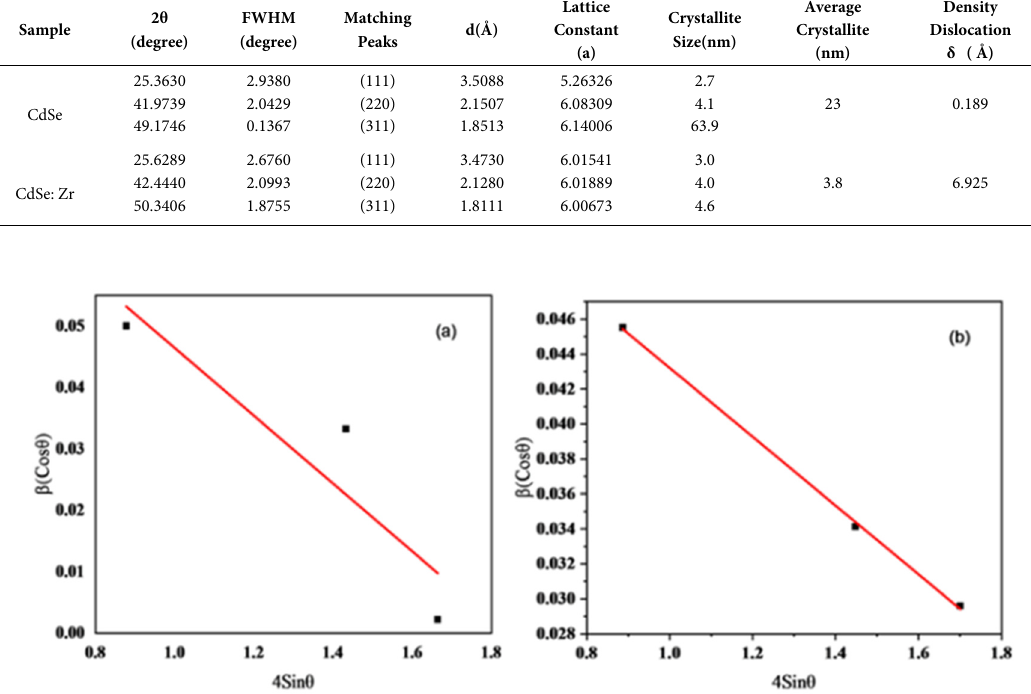
Fig. 2. Williamson-Halls plot of CdSe (a) and Zr-CdSe (b)